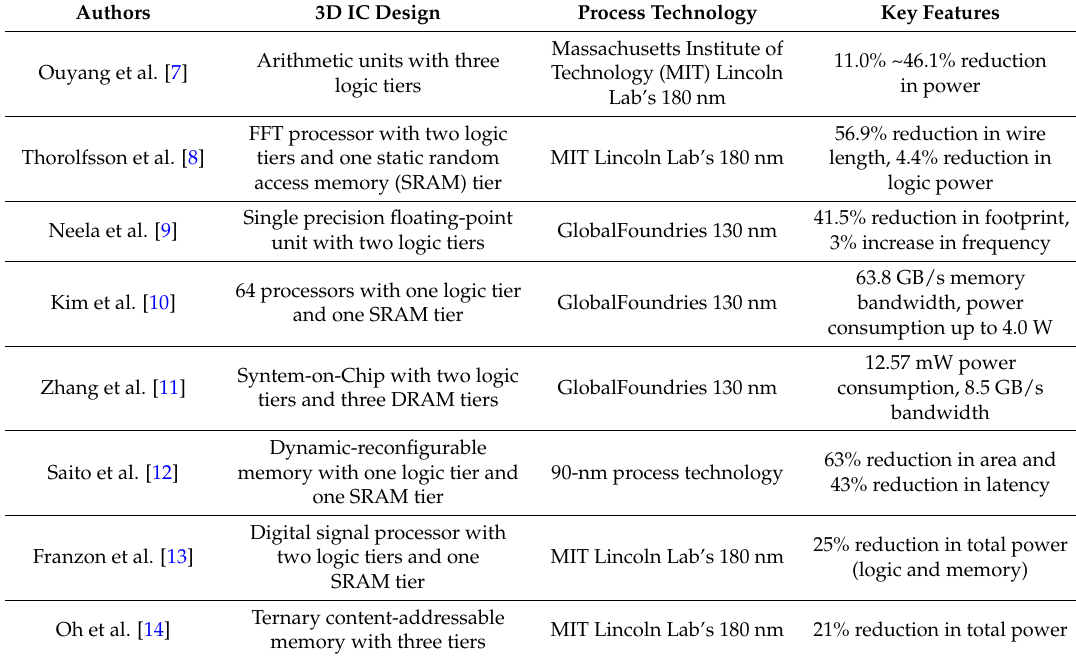
Table 1. Related studies on 3D-stacked IC